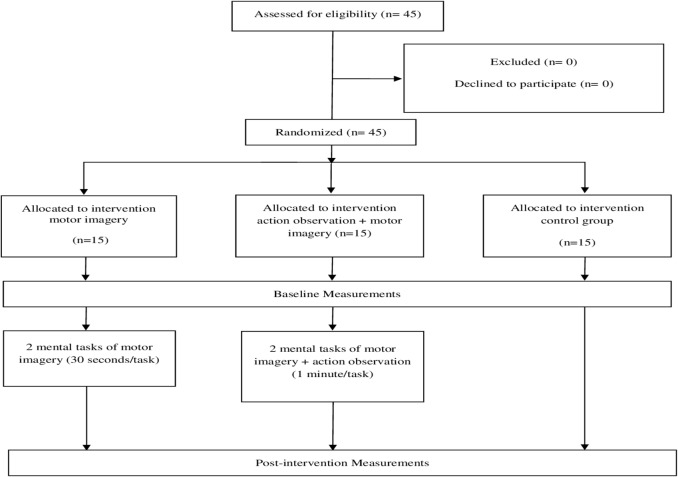
Flow chart of the study design.